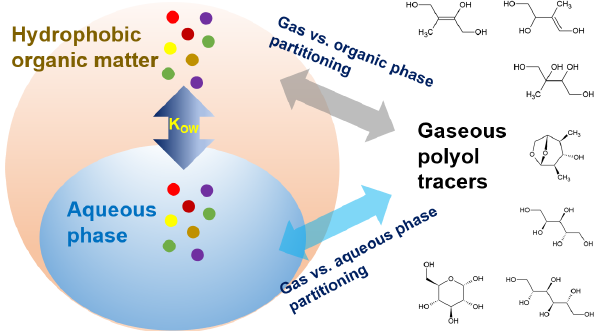
Figure 1. Proposed scheme for gas–particle partitioning of polyol